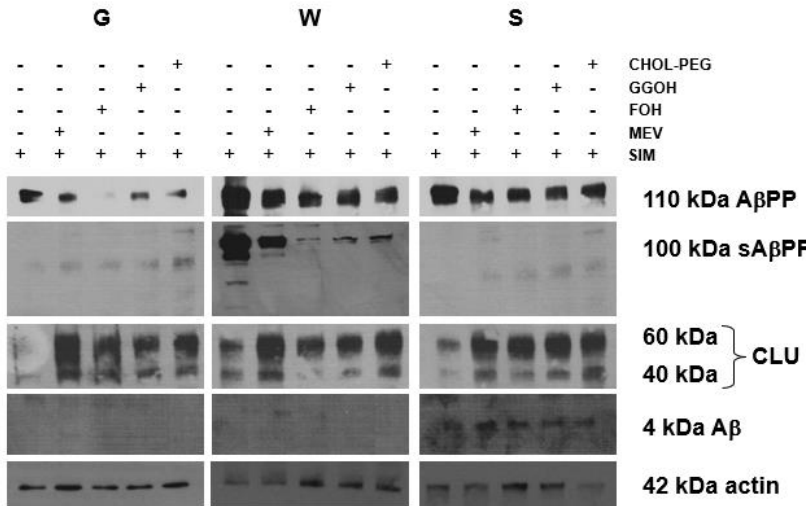
Figure 4. Effect of mevalonate (MEV, 100 µ M), farnesol (FOH, 10 µ M), geranylgeraniol (GGOH, 10 µ M) or water soluble cholesterol (Chol-PEG, 1 mM) on selected protein expressions in cells affected by MEV pathway modulators ( A for atorvastatin – ATR, B for simvastatin – SIM). Western blot analysis of proteins: amyloid precursor protein (A β PP, 110 kDa), soluble amyloid protein precursor alpha (sA β PP α , 100 kDa), clusterin (CLU, 60 and 40 kDa), amyloid- β 1-16 (A β , 4 kDa), actin (42 kDa) as house-keeping protein in empty vector (G), A β PP wild type gene ( A β PP -wt, W), and A β PP Swedish mutations gene ( A β PP -sw, S) transfected cells. The results are indicative of three independent experiments with similar